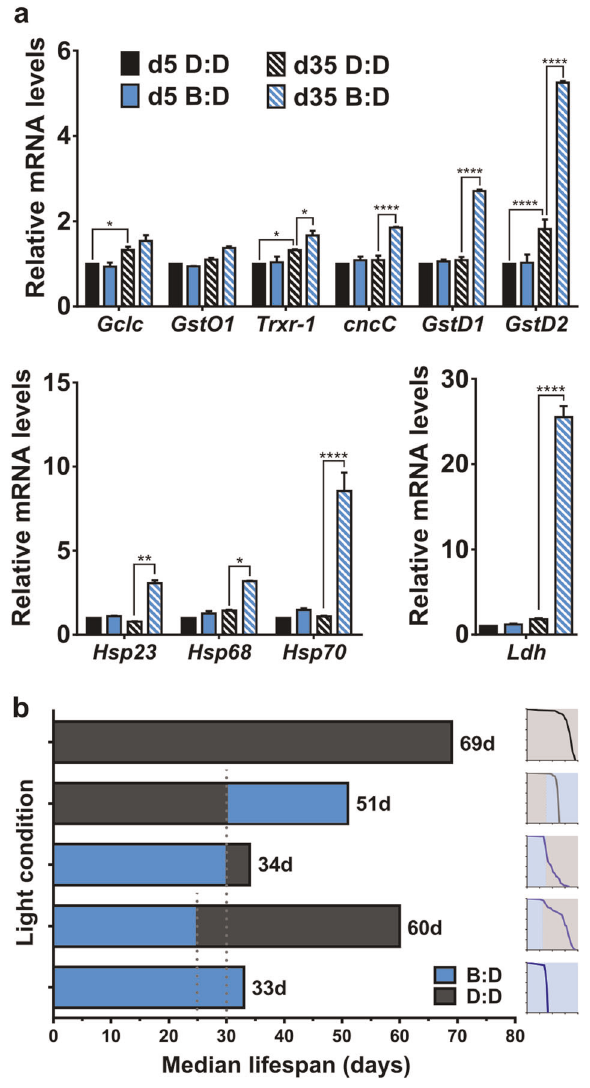
Fig. 6 Flies maintained in blue light show induction of stress- response genes by day 35. a Expression levels of the indicated stress-response genes in heads of 5- and 35-day-old w males maintained in B:D or D:D. For each gene measured, values from qPCR are reported as fold change relative to expression in young fl ies in D:D set as 1. Statistics by 2-way ANOVA (**** p < 0.0001; ** p < 0.01; * p < 0.05). Bars show the average of two biorepeats; error bars show SEM. b Median lifespan of w fl ies exposed to B:D and/or D:D for the durations indicated by blue or black bars. Flies kept in B:D for the fi rst 30 days of adulthood and then transferred to D:D had a similar median survival to those kept in B:D throughout their entire life, while fl ies kept in B:D for the fi rst 25 days of adulthood were able to survive much longer (Log-rank test, p < 0.0001). Flies kept in D:D for the fi rst 30 days of adulthood experienced an increased mortality rate upon transfer to B:D. Mortality curves for each condition are shown on the that the effects of light on retinal versus organismal aging may be mediated by different mechanisms. A surprising outcome of our study is that blue light not only damaged the retina, but also caused neurodegeneration in the brain. A signi fi cant age-speci fi c increase in the area of vacuoles indicative of neuronal death was observed in brains of fl ies in B:D